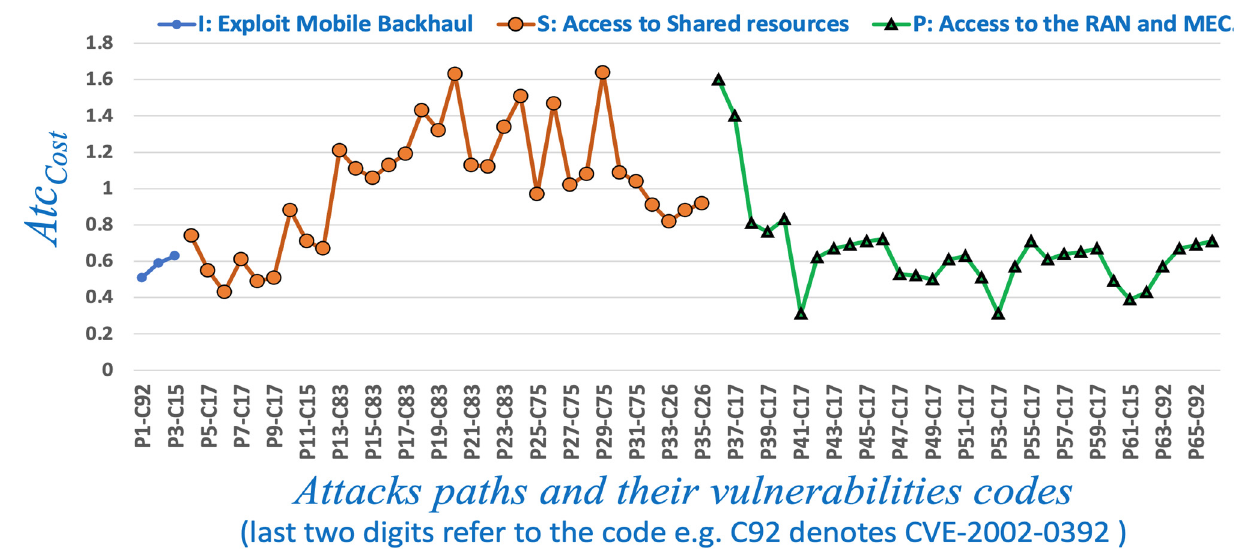
Figure 11. The I , S , and P attack costs and paths.